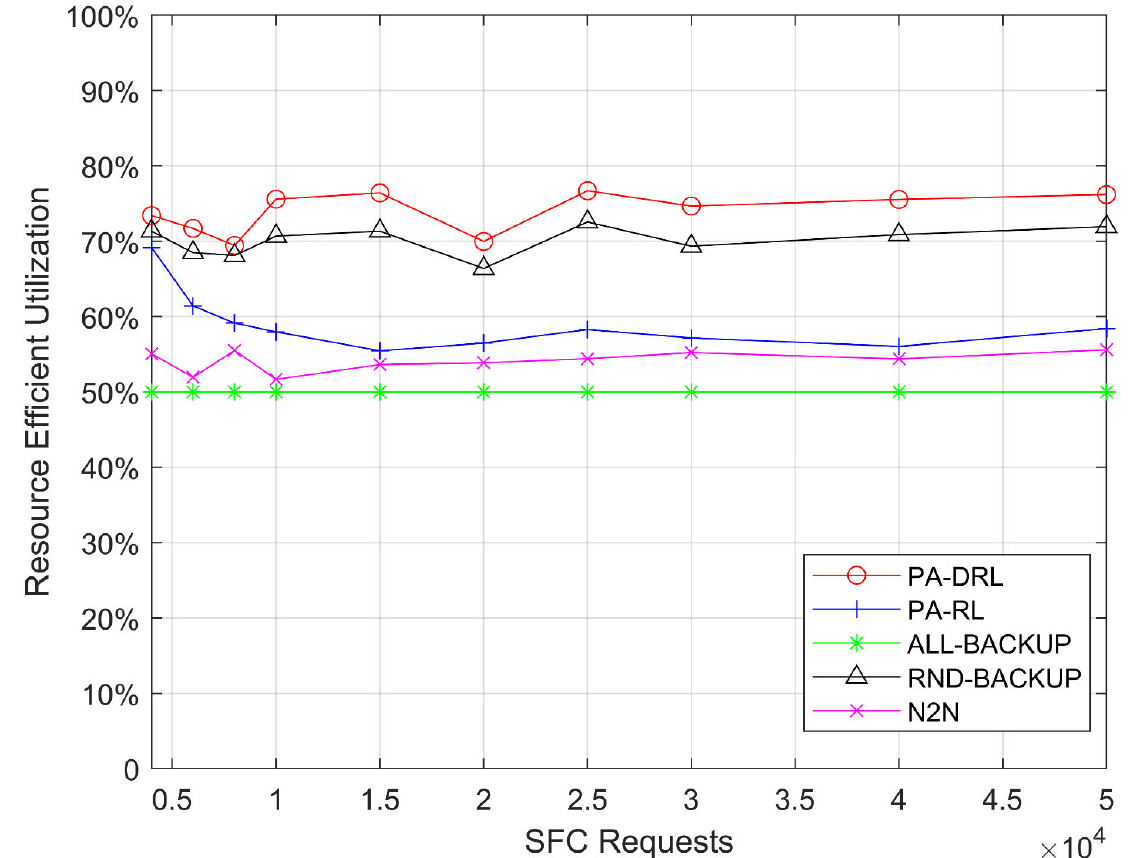
Figure 3. Efficient utilization of CPU resource under each SFC requests number.